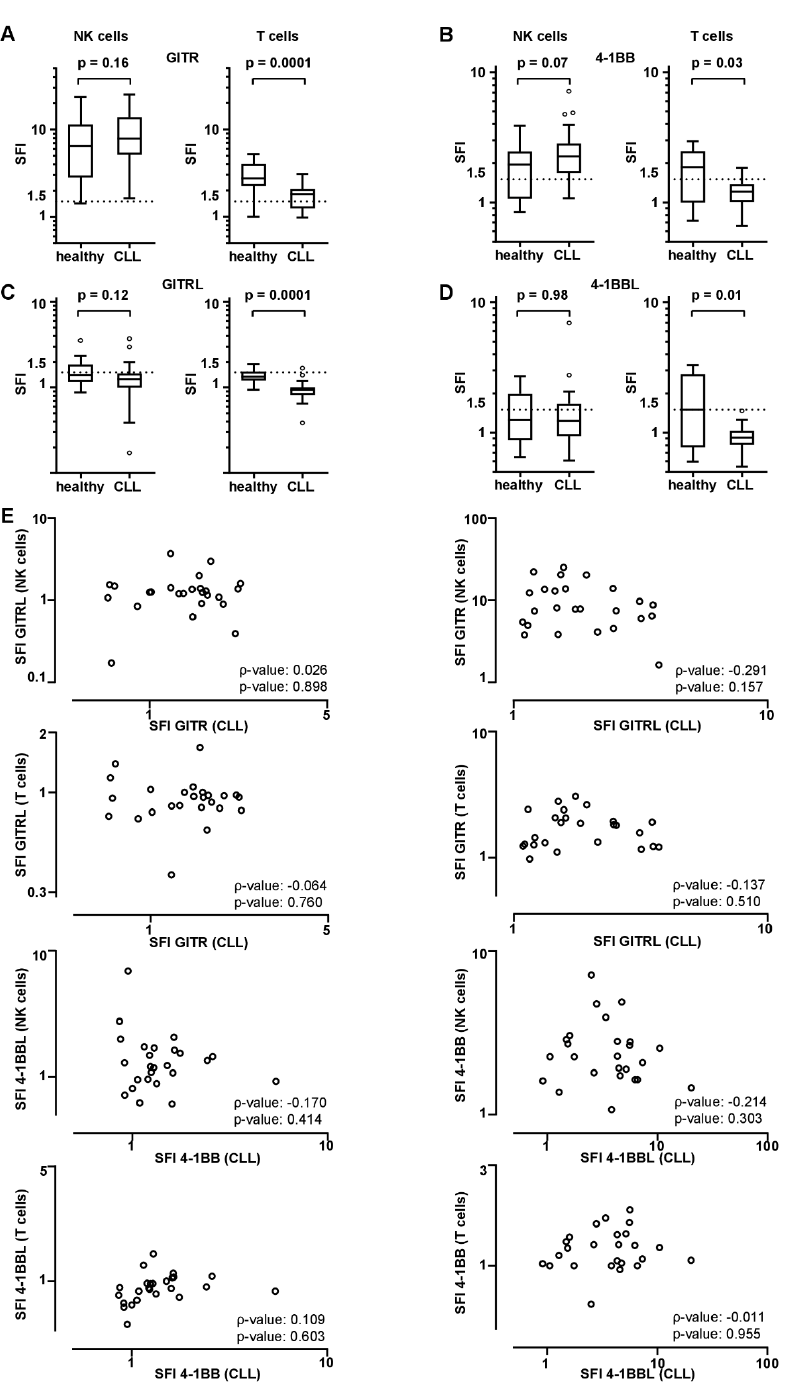
Figure 2. GITR/GITRL and 4-1BB/4-1BBL expression on peripheral NK and T cells of CLL patients and healthy individuals. GITR/GITRL/4-1BB/4-1BBL expression levels were analyzed on NK and T cells by flow cytometry. ( A – D ) GITR/GITRL/4-1BB/4-1BBL expression levels on peripheral NK and T cells of CLL patients ( n = 25) and healthy donors ( n = 15) are demonstrated as SFI levels of GITR, GITRL ( A , C ), 4-1BB, and 4-1BBL ( B , D ) positive samples (boxplots with min/max whiskers). ( E ) Correlation of GITR and GITRL, and 4-1BB and 4-1BBL SFI levels on CLL cells vs. NK or T cells is shown (single values, spearman correlation (ρ)). ( A – D ) Statistical analysis with Mann-Whitney-U test.